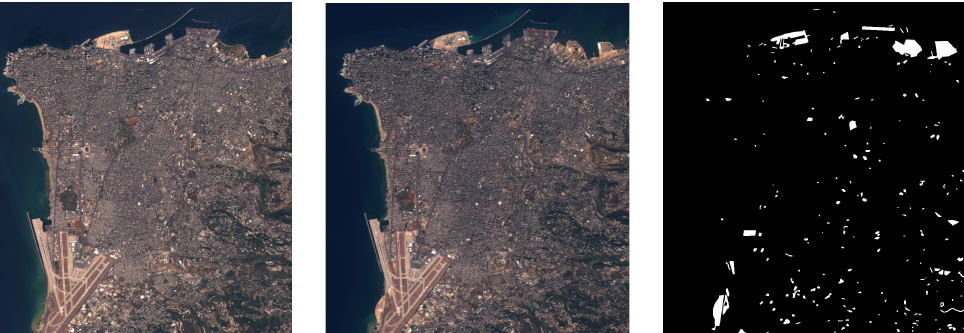
Figure 1. Sample image pair and corresponding ground truth of the Beirut area. Left is the image before changes (20 August 2015), center is the image after changes occurred (3 January 2017), and right is the change map based on ground truth. White pixels map the changes detected in the scene